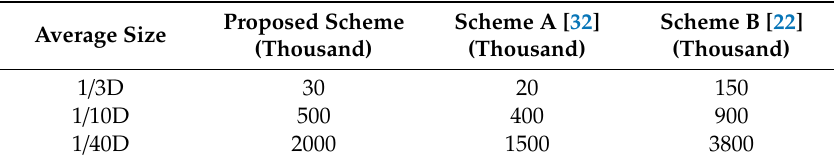
Table 4. Mesh number for three Figure 14. Distribution of turbulence intensity on the z = 0 plane.